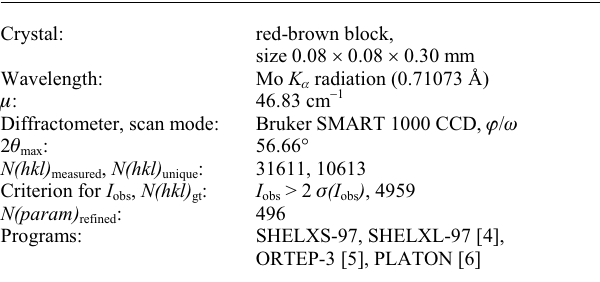
Table 1. Data collection and